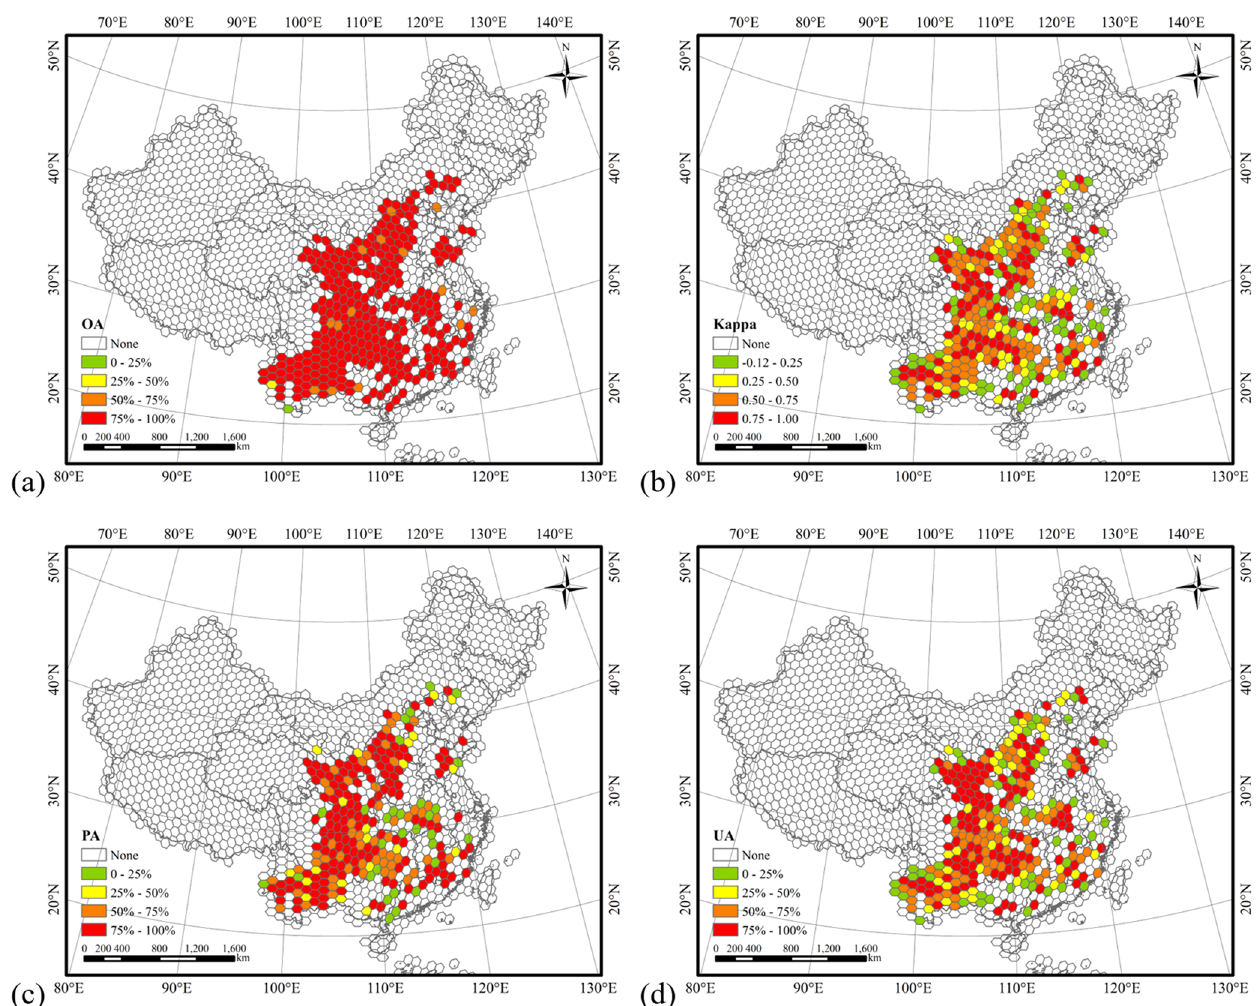
Figure 6. Spatial variation of (a) OA (only calculated for hexagons with terrace test samples or with non-terrace test samples classified as terrace class), (b) kappa, (c) PA of terrace class, and (d) UA of terrace